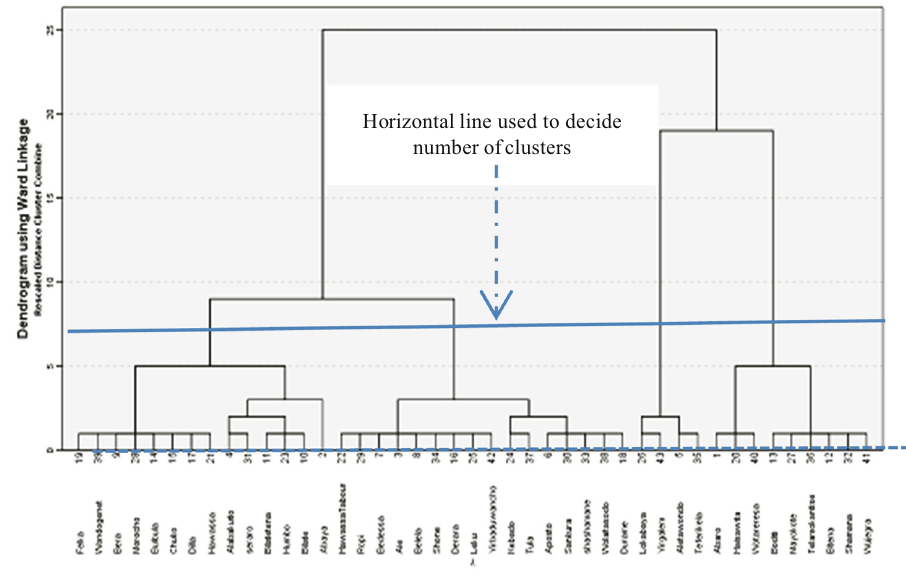
Figure 6: Dendrogram using ward linkage.